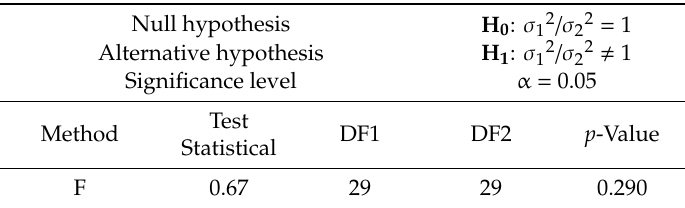
Table 11. Equality of variances test.